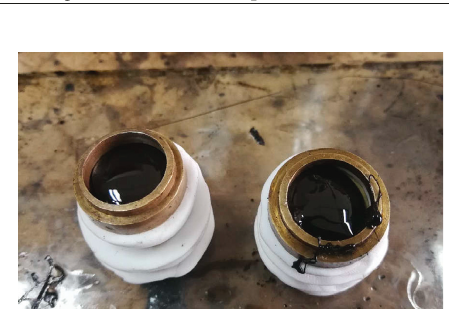
Figure 1: Test molds of the improved softening point